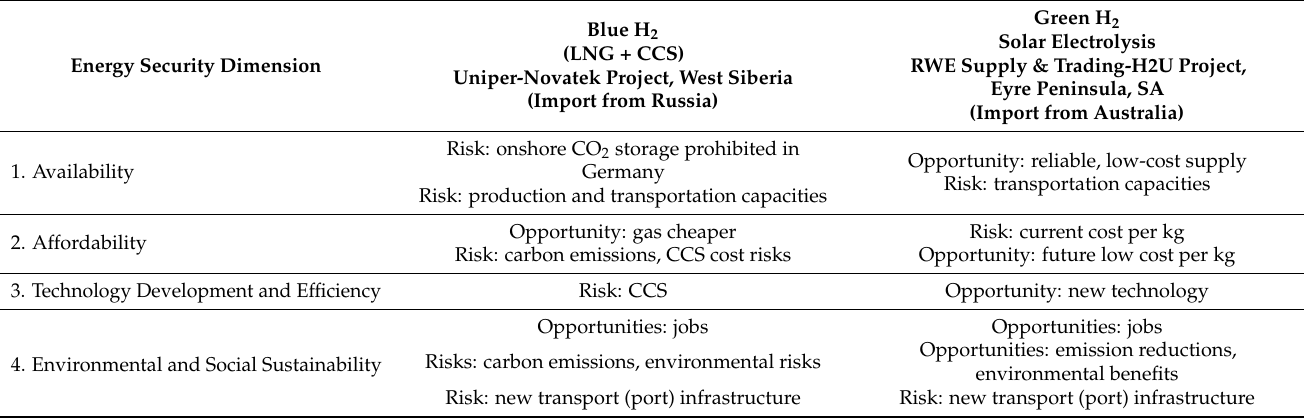
Table 3. Risk and opportunity analysis across applied seven-dimension energy security-justice framework: German projects.